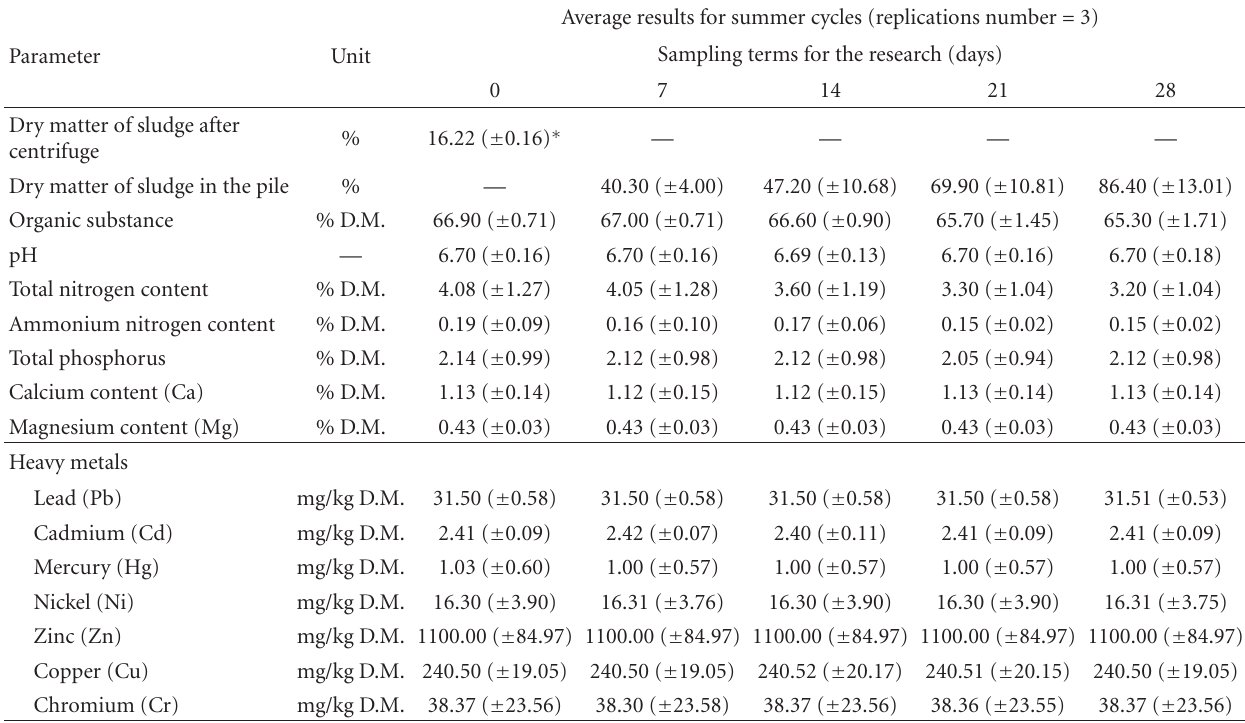
Table 2: Average results of physicochemical analyses of sewage sludge in summer cycles.